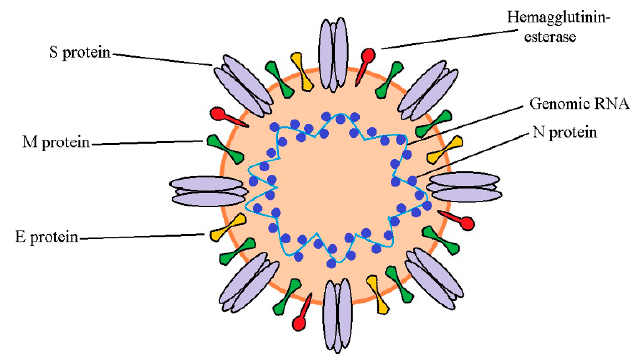
Figure 2. Structure of SARS-CoV-2 virus.